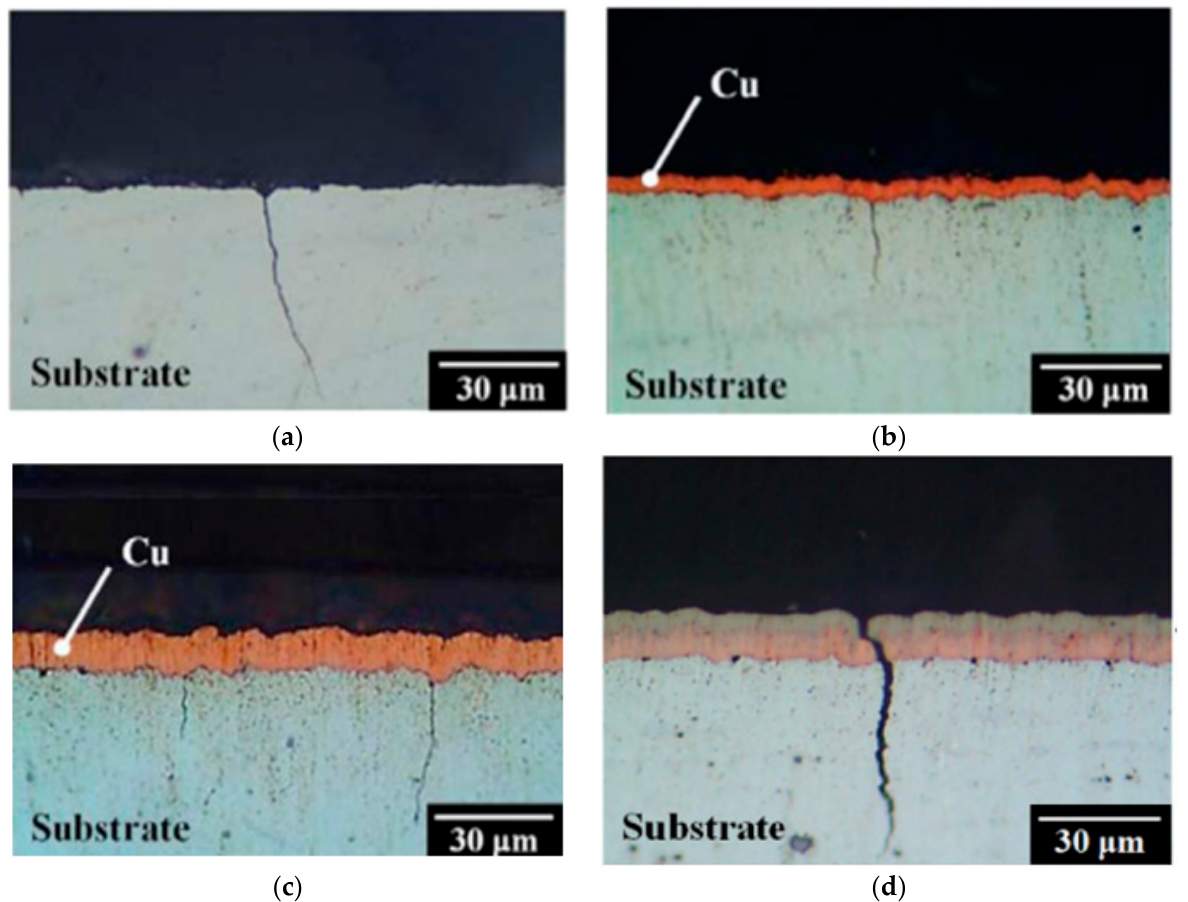
Figure 11. LCF fracture behavior of Mg alloy after ( a ) uncoated AZ61 specimen, ( b ) alkaline Cu-, ( c ) alkaline followed by acidic Cu-, and ( d ) Ni-Cu “Reused with permission from Elsevier by License No. 5494631394332” [82]. Table 7. The summary of novel research on the AZ61 magnesium alloys.